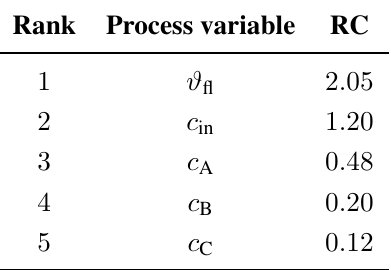
Table 3. Root cause priority list calculated from the causal matrix in Figure 2.